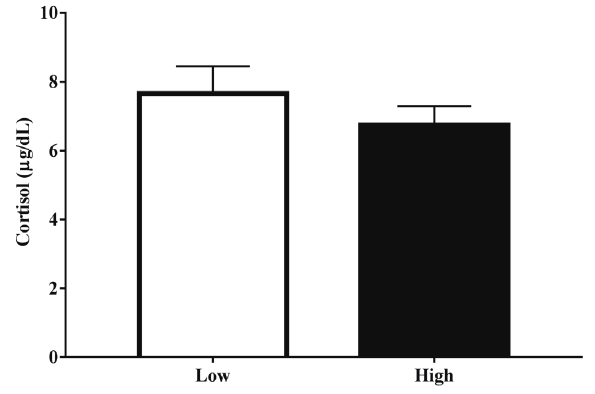
Figure 2. Influence of drip loss on serum cortisol levels in pigs (n = 10 per